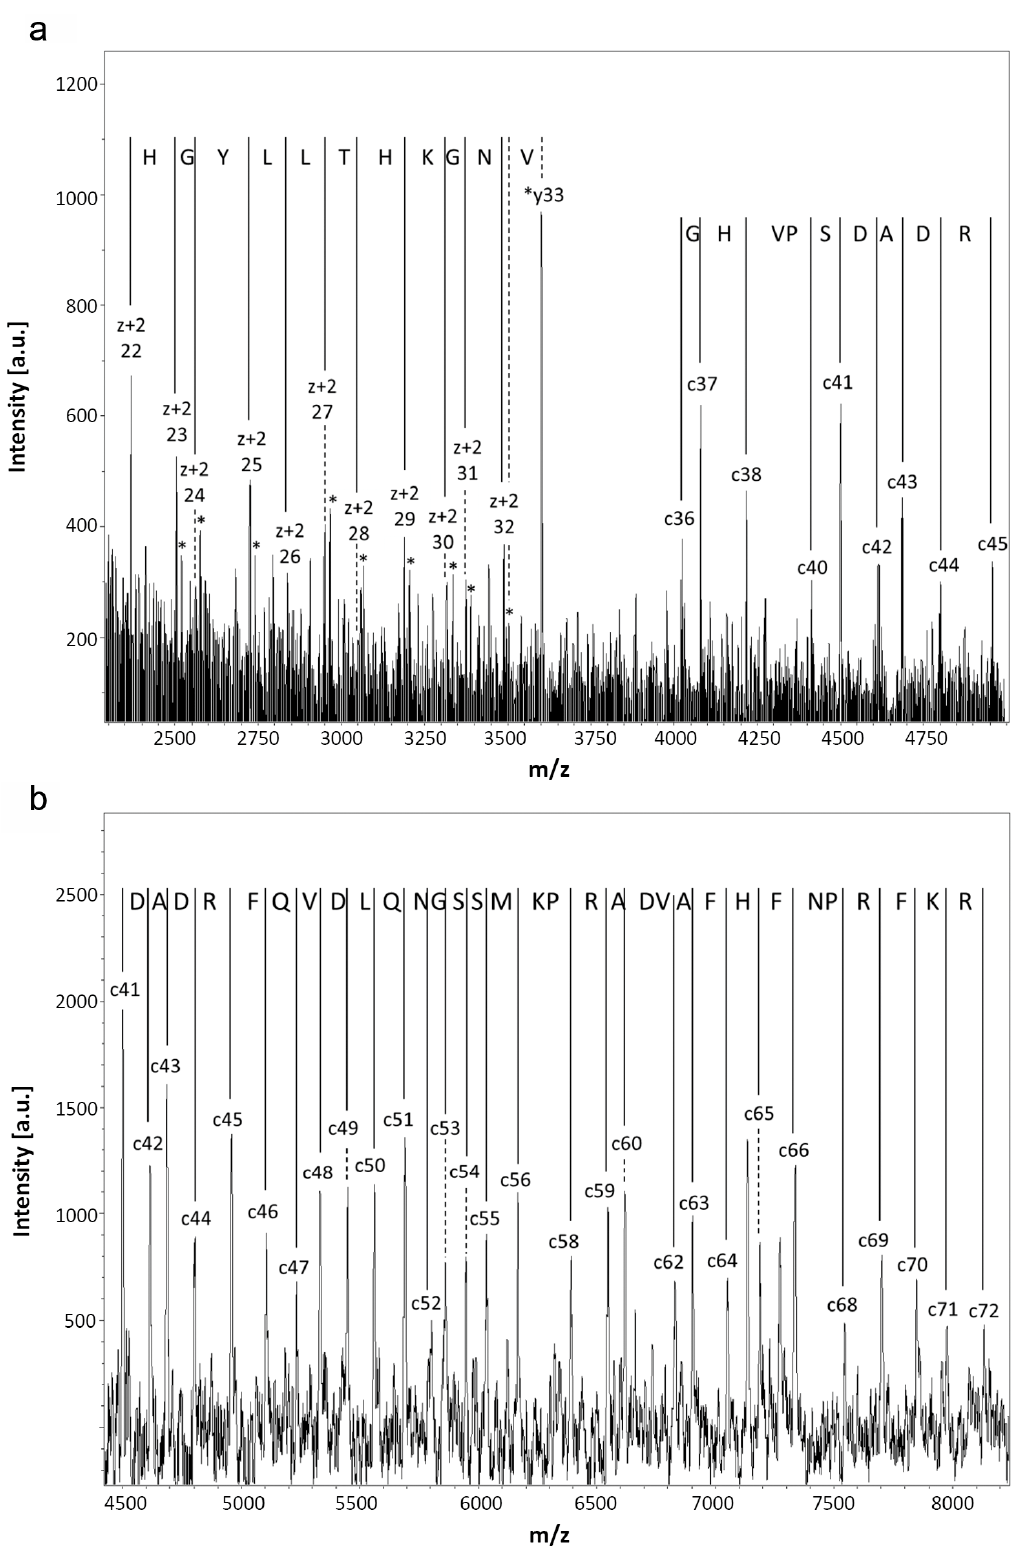
Figure 5. Mass determination and peptide ladder of N- and C-terminal regions by re/linISD for Gal-8 (NN). ( a ) reISD spectrum with the smallest C (left)- and N (right)-terminal peptides and the ensuing peptide ladder; ( b ) linISD spectrum with the smallest detectable N-terminal peptide and the ensuing peptide ladder.